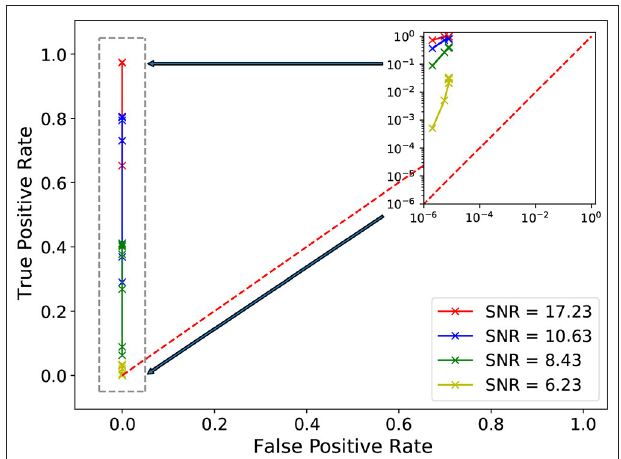
FIGURE 6 | Receiver operating characteristic curve of TensorRT AI ensemble. The output of our inference-optimized AI ensemble is used to estimate the true positive rate with a test set of 237,663 modeled waveforms whitened with advanced LIGO data, and which cover a broad range of signal-to-noise ratios. The false positive rate is computed using a 5 year long time-shifted advanced LIGO dataset. The gray dashed rectangle in the left of this panel is shown in detail in the top right inset.